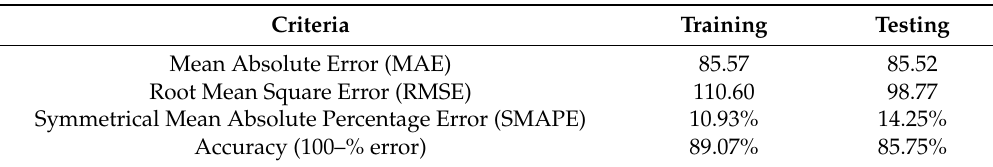
Figure 7. Results of the ANFIS model. ( a ) Degree of Polymerization prediction results of 76 training transformers; ( b ) Residual value of DP target and prediction results of 32 testing transformers; ( c ) Residual value of DP target and prediction results of 76 training transformers; ( d ) Residual value of DP target and prediction results of 32 testing transformers. Table 12. Evaluation criteria of the model.